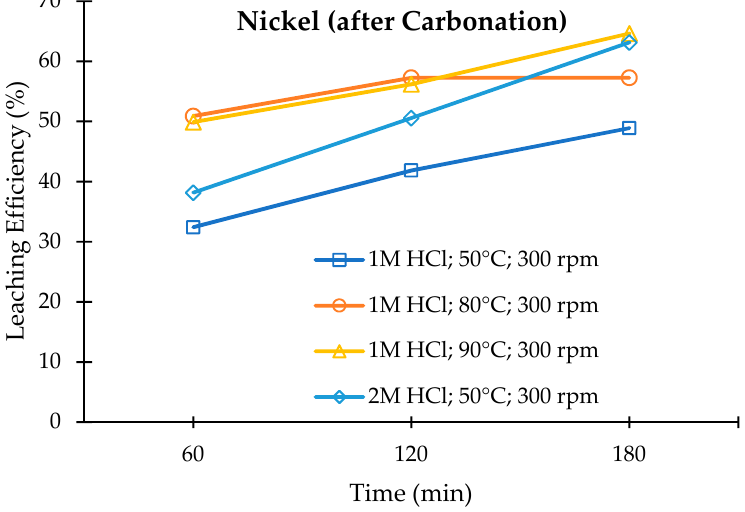
Figure 11. Leaching efficiency of nickel from a carbonated olivine depending on concentration of hydrochloric acid and reaction temperature for the fraction 20–63 µm.